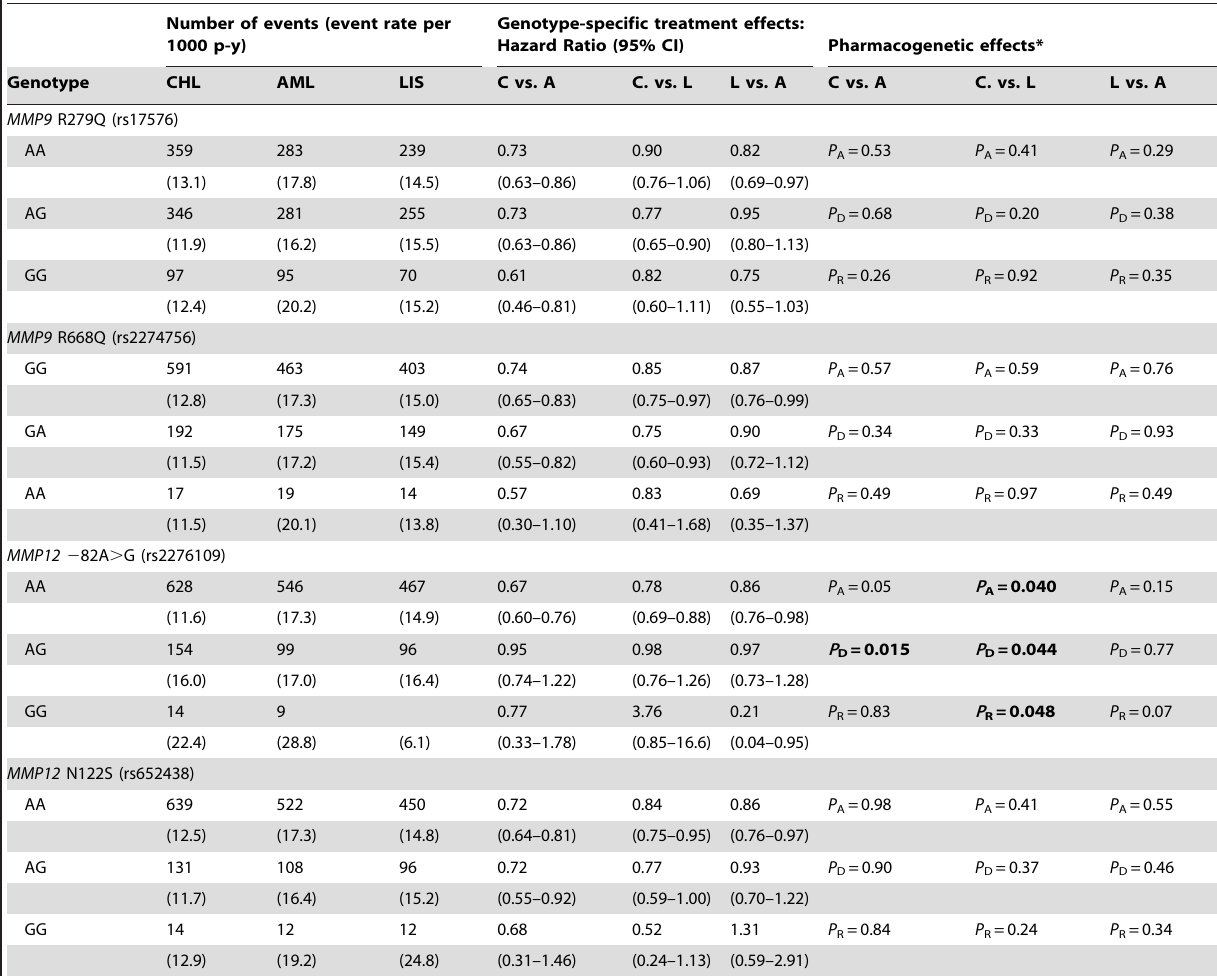
Table 8. Pharmacogenetic effects of MMP genetic variants on CHF.